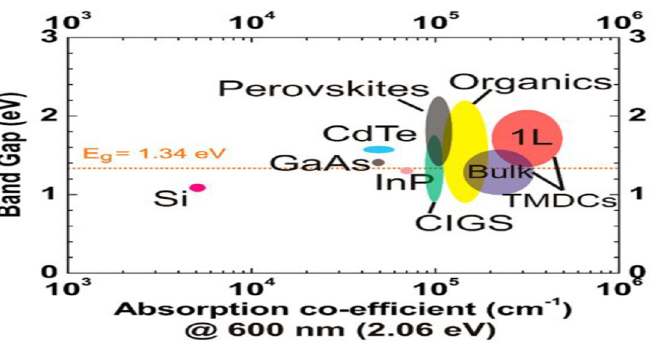
Figure 7. Energy of the band gap and coefficients of absorption for the main photosensitive materi- als investigated on a commercial and research scale [25]. investigated on a commercial and research scale